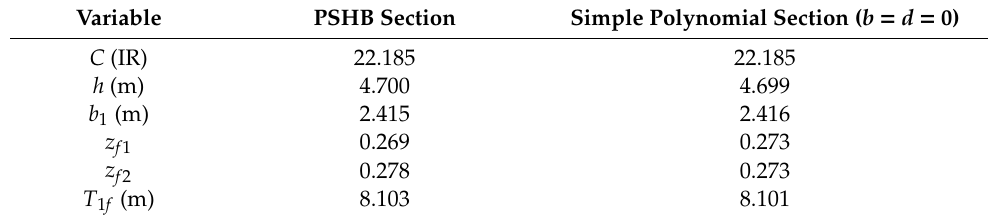
Table 3. Comparison of minimum construction costs of the special case of simple polynomial section and parabolic sides and a horizontal bottom (PSHB) Section 1